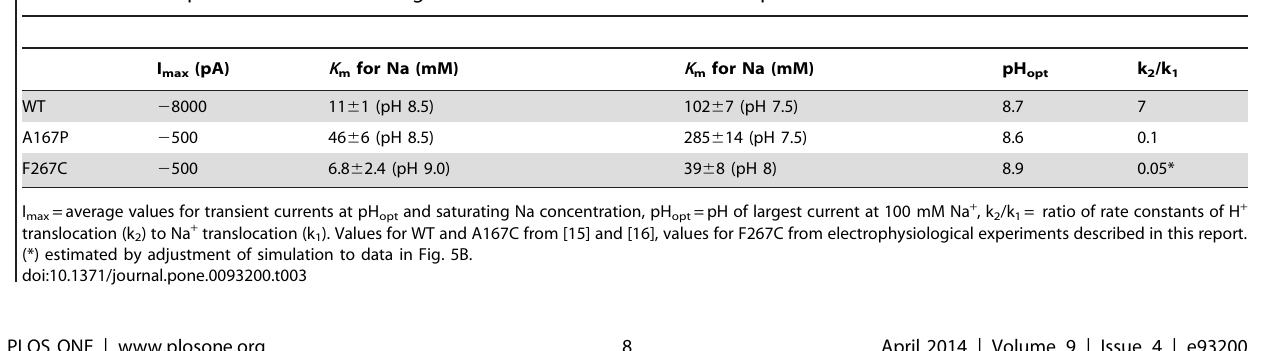
Table 3. Kinetic parameters of the voltage insensitive NhaA mutants in comparison with the WT.